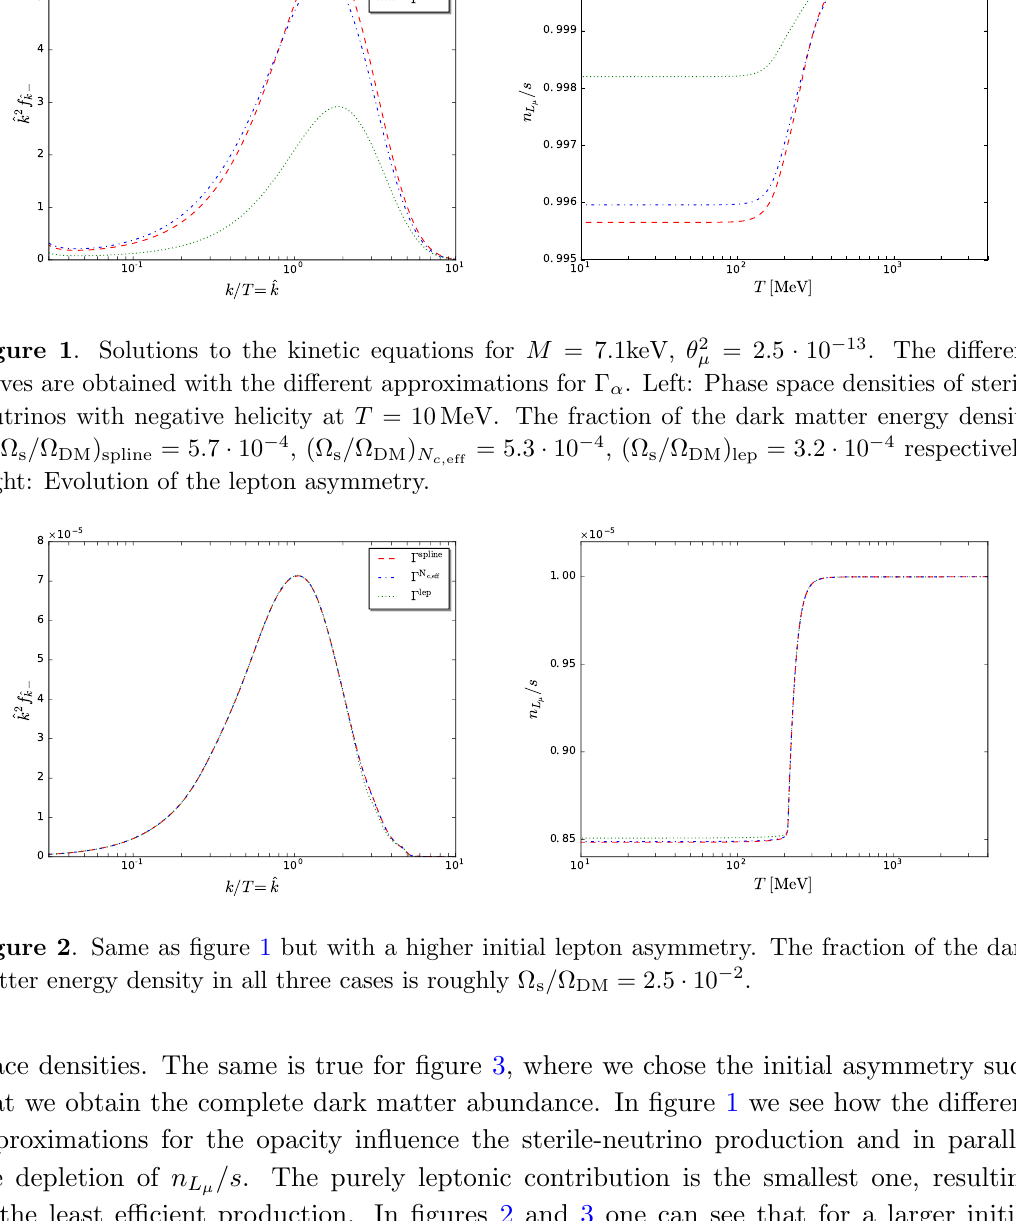
space densities. The same is true for (cid:12)gure 3, where we chose the initial asymmetry